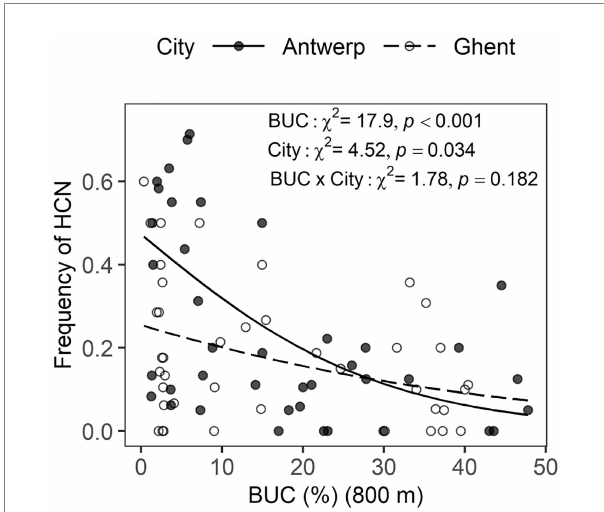
FIGURE 1 Frequency of HCN within populations of Trifolium repens along urbanization gradients (BUC) within a 800-meter radius in the cities (City) of Antwerp and Ghent. A quasibinomial generalized linear model was fitted and model R 2 is 0.63. Number of sampled populations in each city is 40. For each predictor, χ 2 and p value from type-III Chi 2 Wald tests are shown on the plot, while estimates and standard errors are shown in Supplementary Table